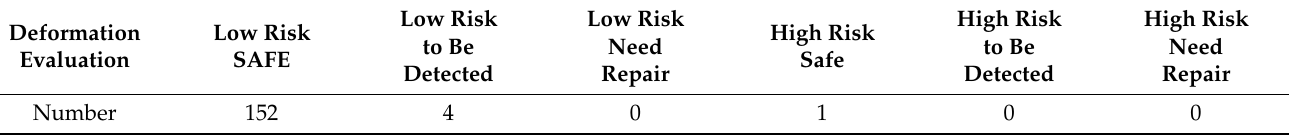
Table 6. Evaluation results of overall deformation of tower head.